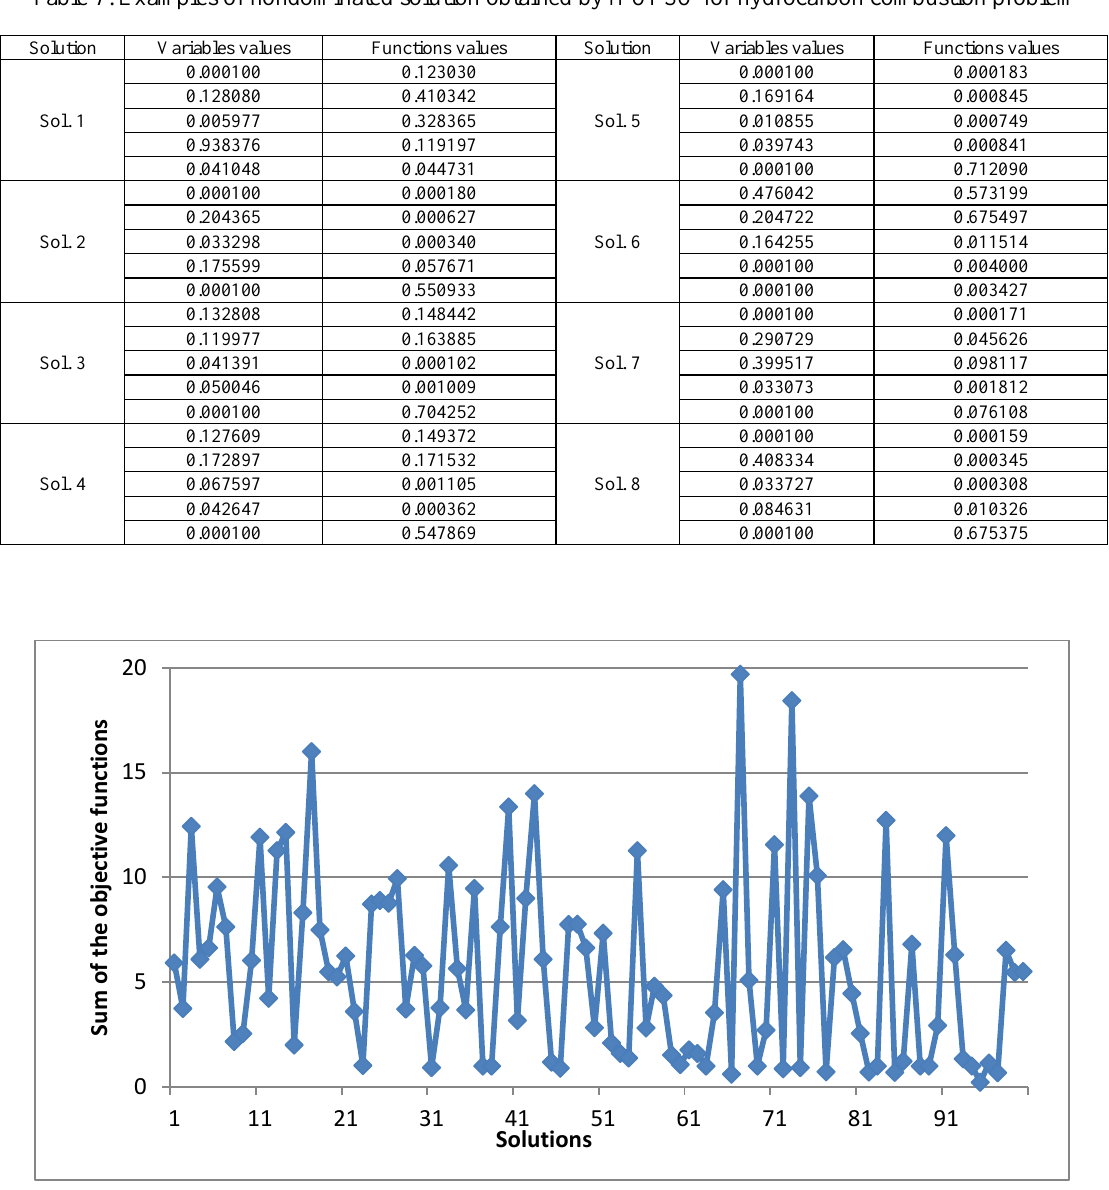
Figure 11 reflects the single solution obtained for hydrocarbon combustion problem by grey wolf optimization algorithm after 200 iterations and with 30 grey